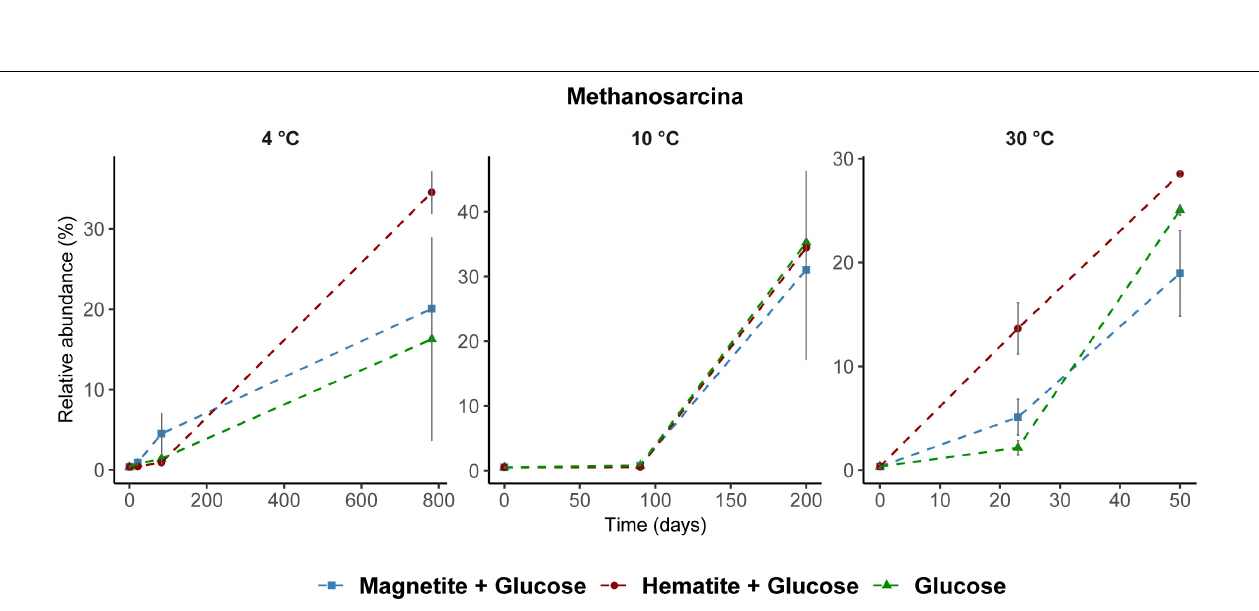
FIGURE 6 | Relative abundance of Methanosarcina spp. across all temperatures determined by archaea 16S rRNA gene analysis. Methanosarcina was the only known methanogen that increased in relative abundance during methane formation regardless of incubation temperature.